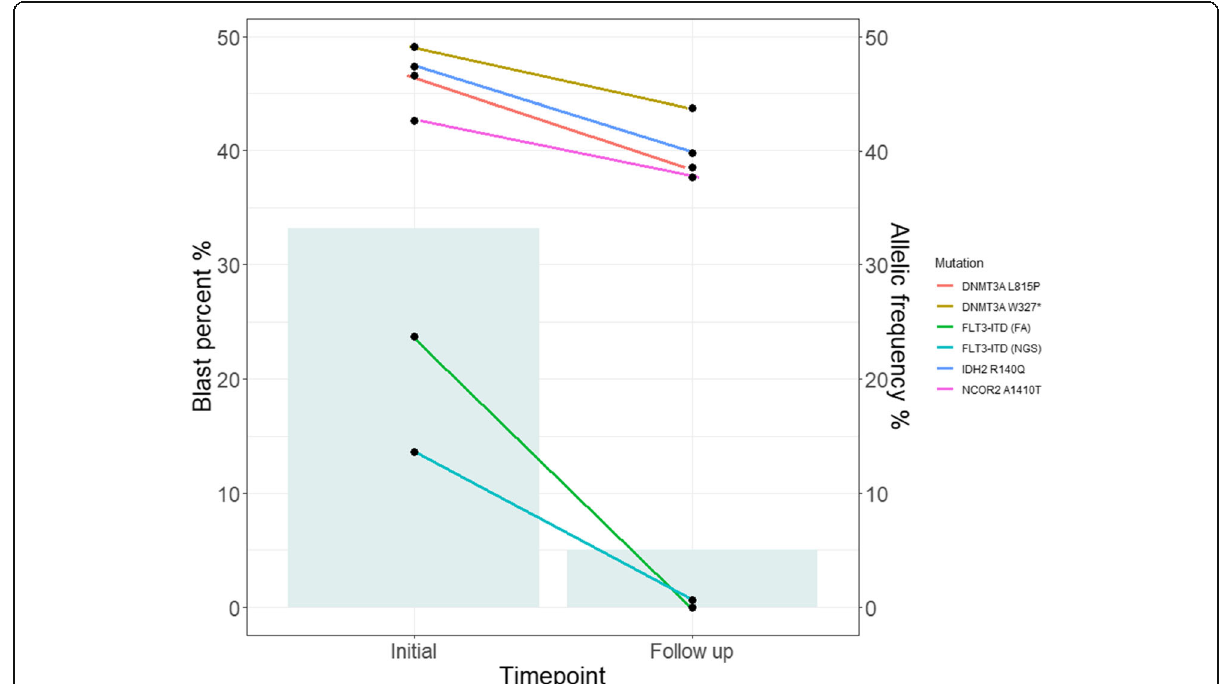
Fig. 3 Change in AF values of somatic mutations in an AML case with discordant results from NGS and fragment analysis, respectively (Patient 7). The FLT3 ITD AR was calculated by fragment analysis was converted into an AF value according to the following equation; AF(%) = AR/(1 − AR)*100. The box represents the blast percentage observed in a bone marrow aspirate smear